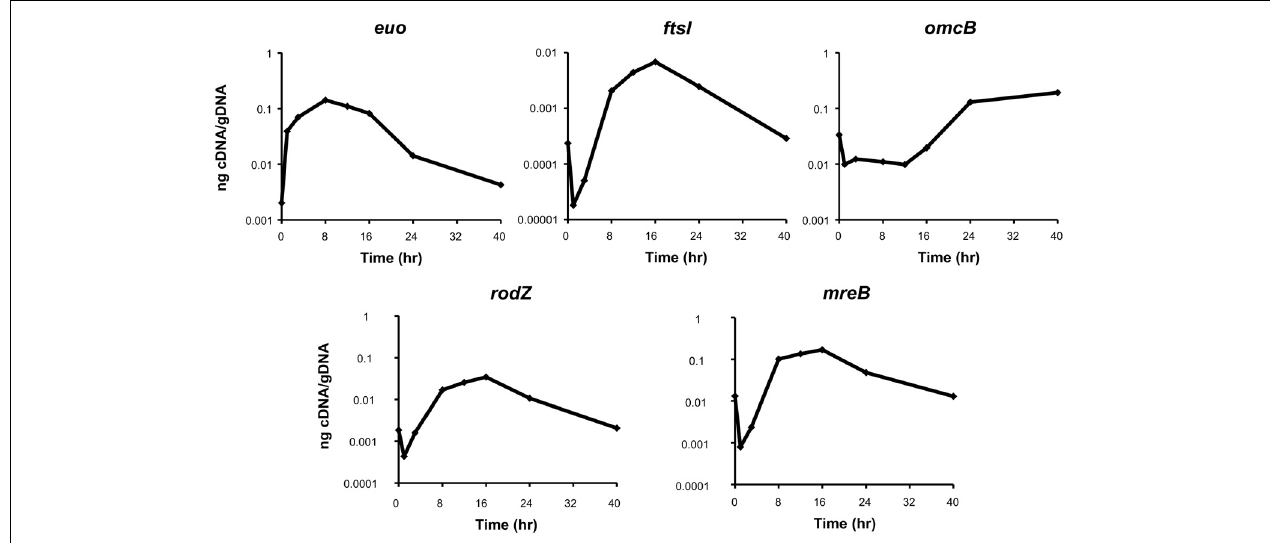
FIGURE 4 | Transcriptional analysis of ct009 / rodZ during the chlamydial developmental cycle. The indicated genes were analyzed by RT-qPCR over a time course of infection with C. trachomatis . The top panels show control genes for EB-to-RB transition ( euo ), RB growth and division ( ftsI ), and RB-to-EB transition ( omcB ). Transcription of rodZ and mreB is shown in the